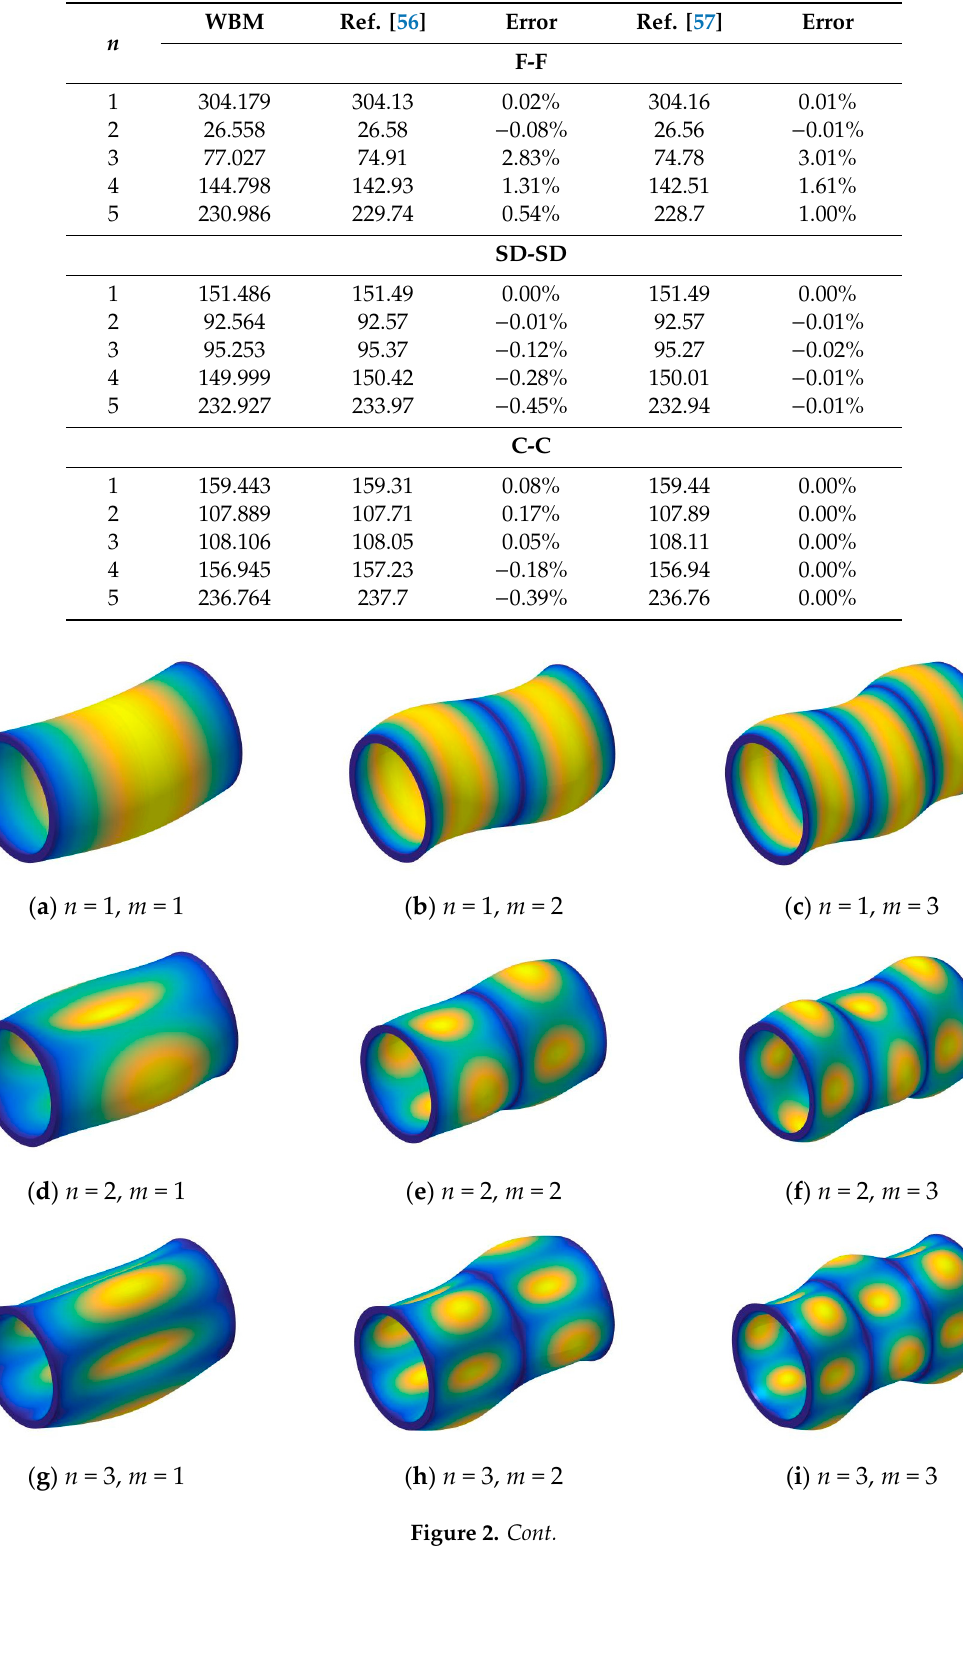
Table 1. Frequency parameters 2 / L E h ω ρΩ = for a three-layer cross-ply cylindrical shell [0 o /90 o /0 o ] 2 with various classical boundary conditions ( R = 1 m, L / R = 5, h/R = 0.05, E 2 = 1 GPa, E 1 / E 2 = 25, μ 12 =